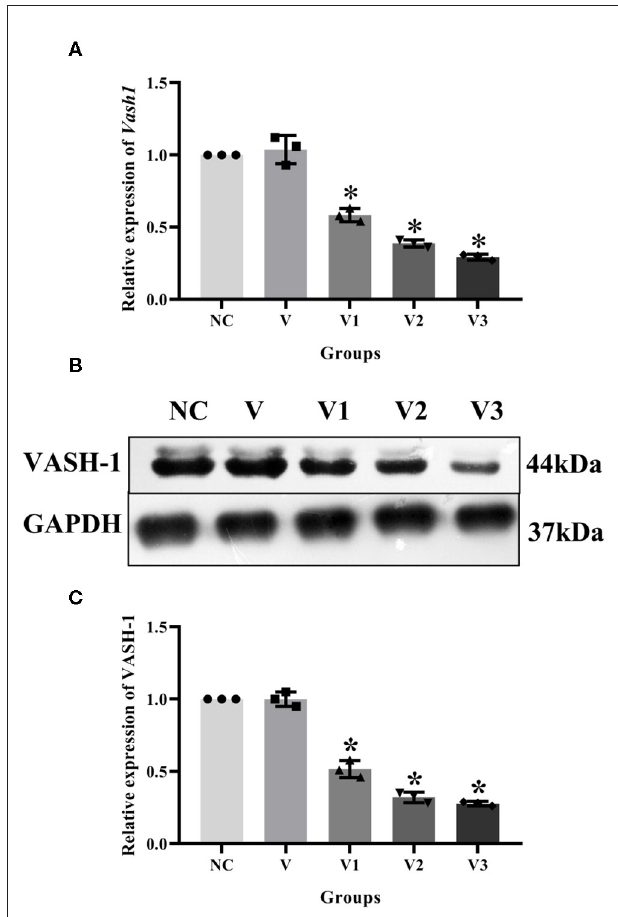
FIGURE 5 | Effects of different Vash1 siRNA transfection fragments on mRNA and protein expression in RMCs. Relative expression levels of (A) Vash1 mRNA, (B) western blot protein bands, and expression levels of (C) VASH-1 protein. *Compared with the NC group, P < 0.05. Data were expressed as mean ± SD, and results were repeated three